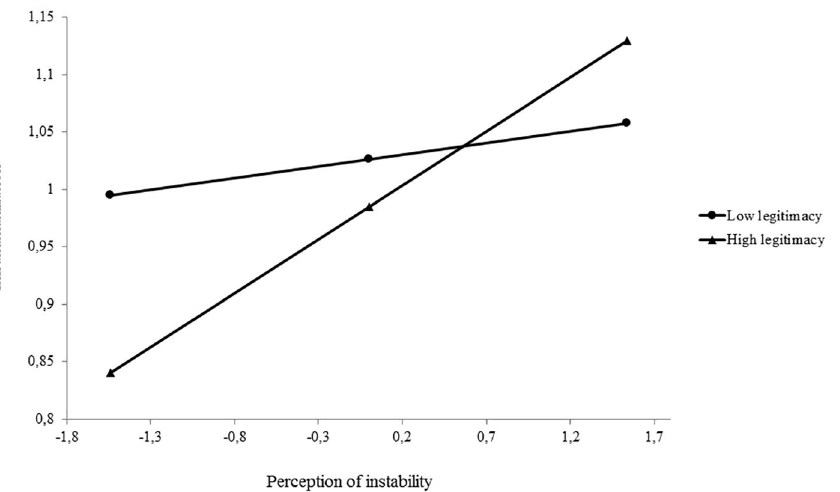
Figure 1. Moderating effect of the perception of status legitimacy on the relationship between the perception of instability and